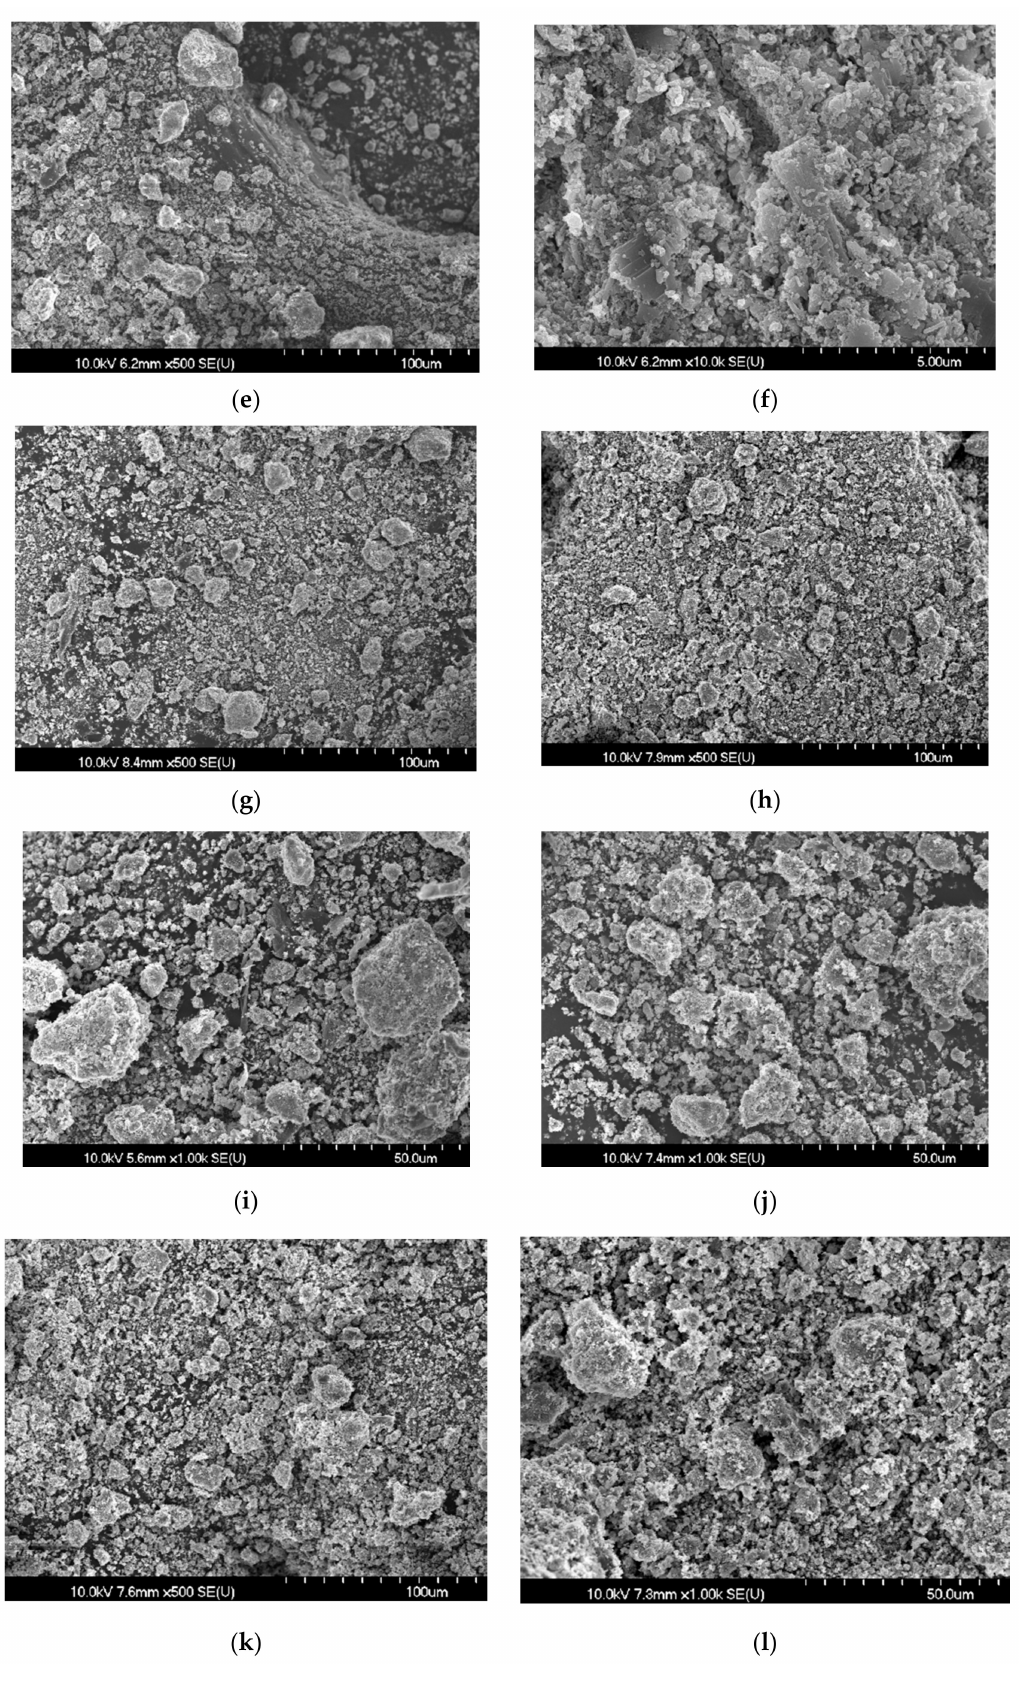
Figure 9. SEM images of final products from low temperature detoxification test. ( a ) ADT-1, ( b )